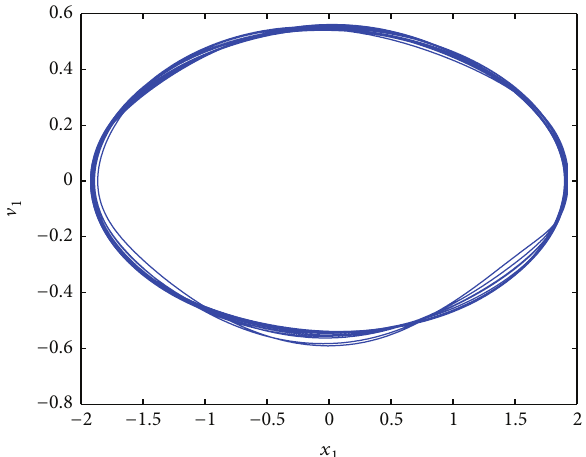
Figure 6: A grazing periodic trajectory of oscillator 𝑀 1 .